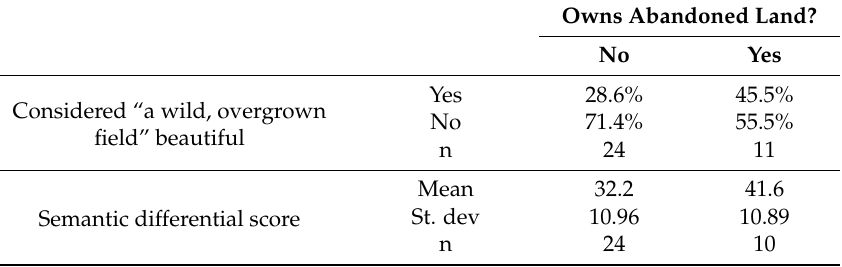
Table 2. Aesthetic perceptions of abandoned land by Allegany County (NY) farmers, contrasting the subgroup who owns abandoned lands with the subgroup that does not. A higher semantic differential score indicates a more positive aesthetic perception of abandoned land.